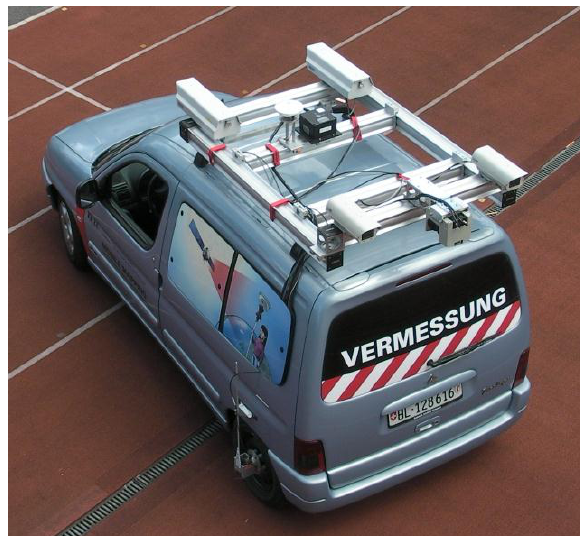
Figure 2. IVGI stereovision mobile mapping system, configured with a forward and a backward looking stereo system and a downward looking profile scanner